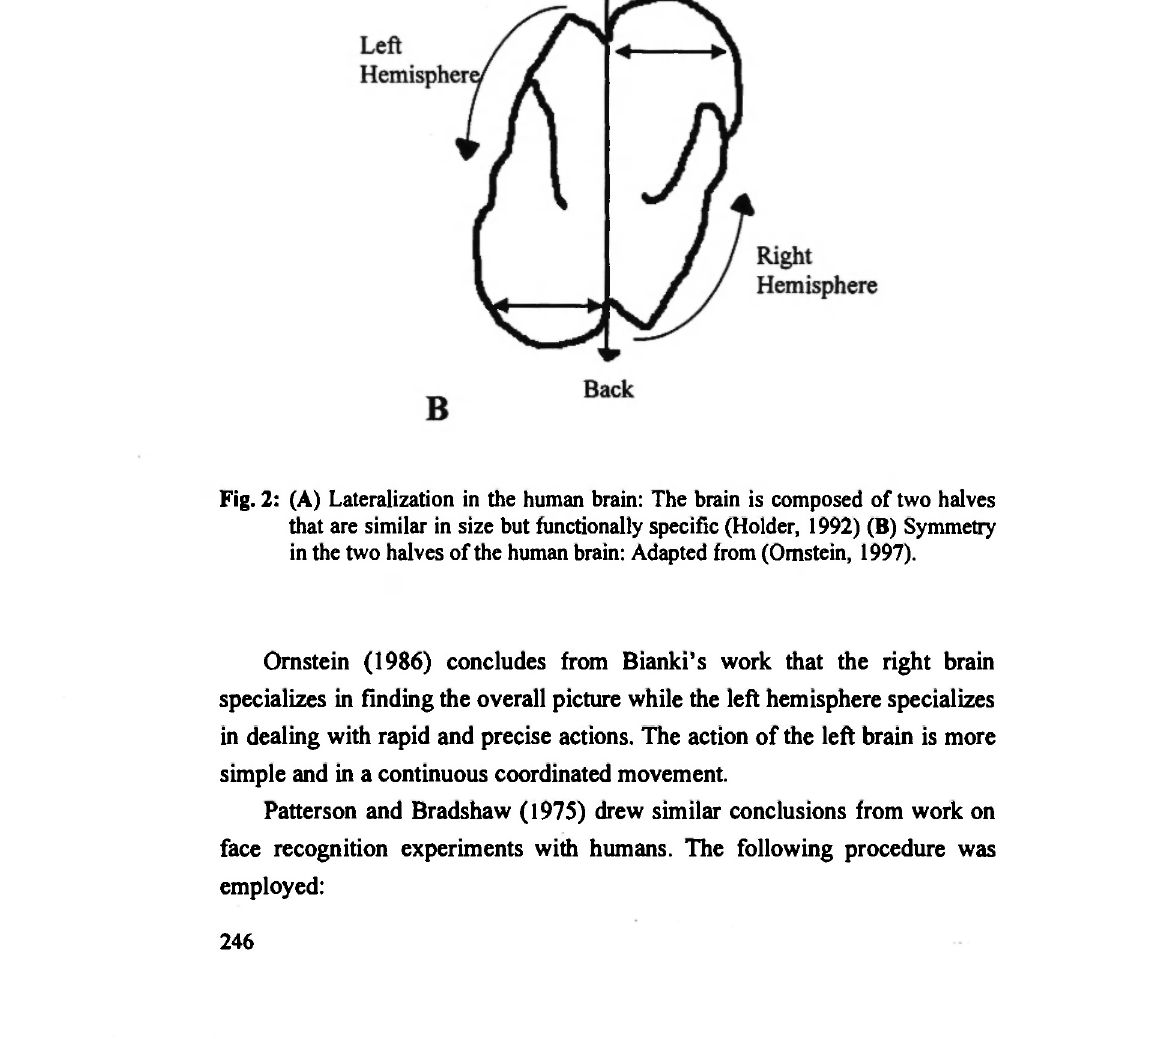
simple and in a continuous coordinated